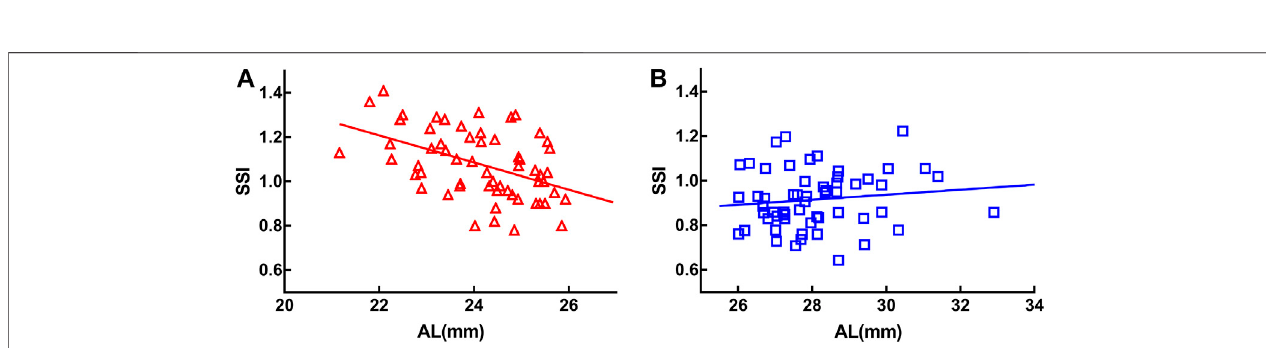
FIGURE2| Stress-strainindex(SSI)wasnegativelycorrelatedwithaxiallength(AL)inthemoderatelyelongatedeyegroup( r (cid:1) − 0.476, p < 0.001) (A) .Therewasno signi fi cant correlation between SSI and axial length in the severely elongated eye group ( p > 0.05) (B) .